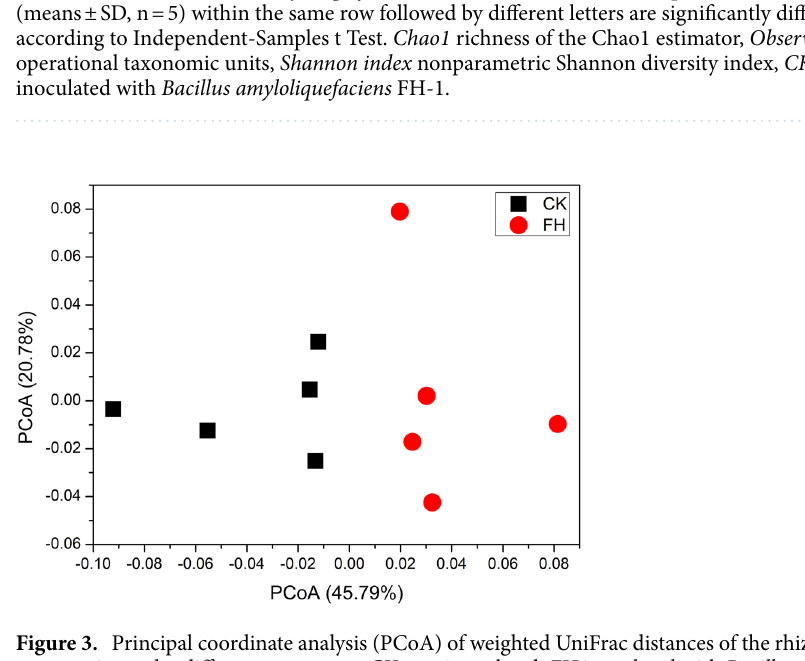
Figure 3. Principal coordinate analysis (PCoA) of weighted UniFrac distances of the rhizosphere bacterial community under different treatments. CK non-inoculated, FH inoculated with Bacillus amyloliquefaciens